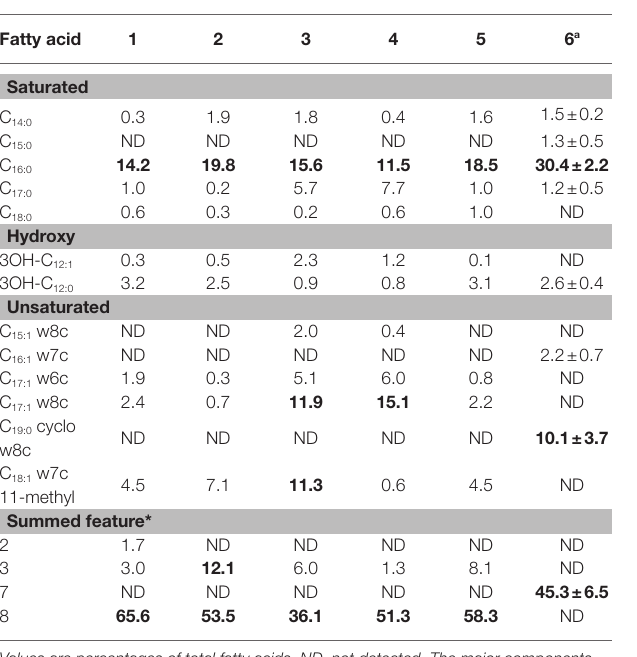
TABLE 2 | Cellular fatty acid profiles (>1%) of strain GR-TSA-9 T and its closely related species.